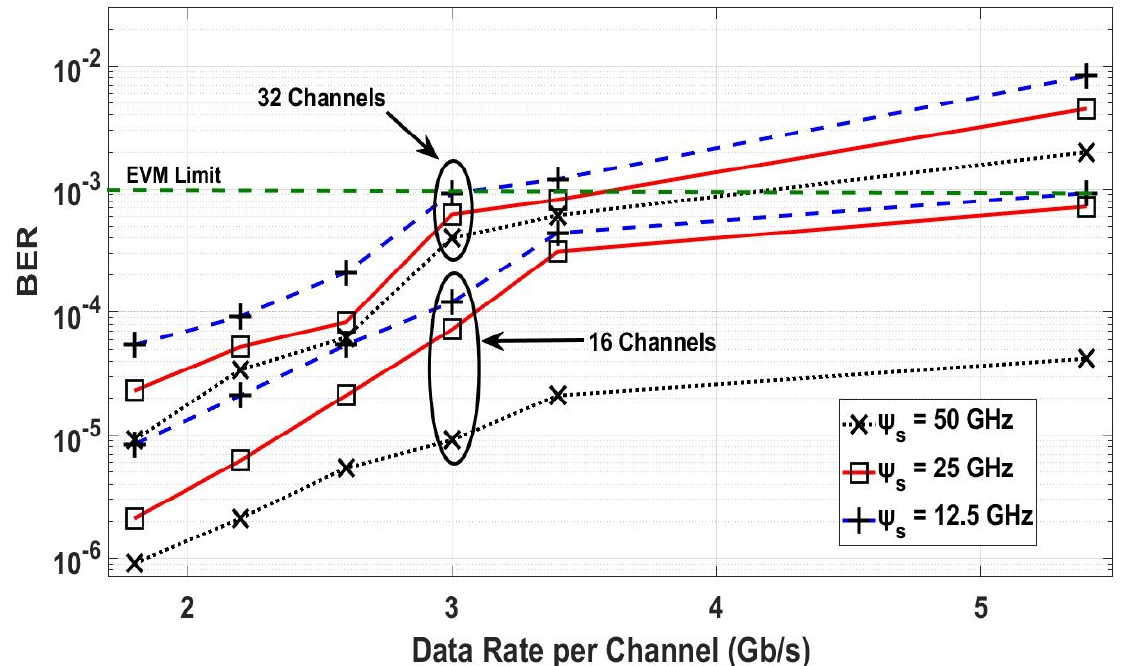
Figure 12. Data rate per channel with 12.5, 25, and 50 GHz channel spacing, for 16 and 32 number of